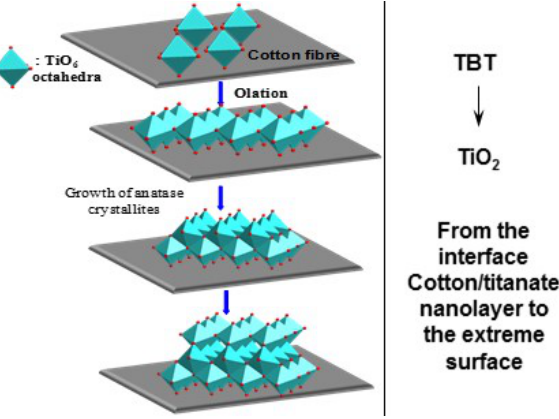
Figure 3: Schematic nucleation and growth of octahedral anatase crystals during the hydrothermal treatment, leading to Cotton-TiO hybrid structures [24]; reprinted (modified) with permission from Royal Society of